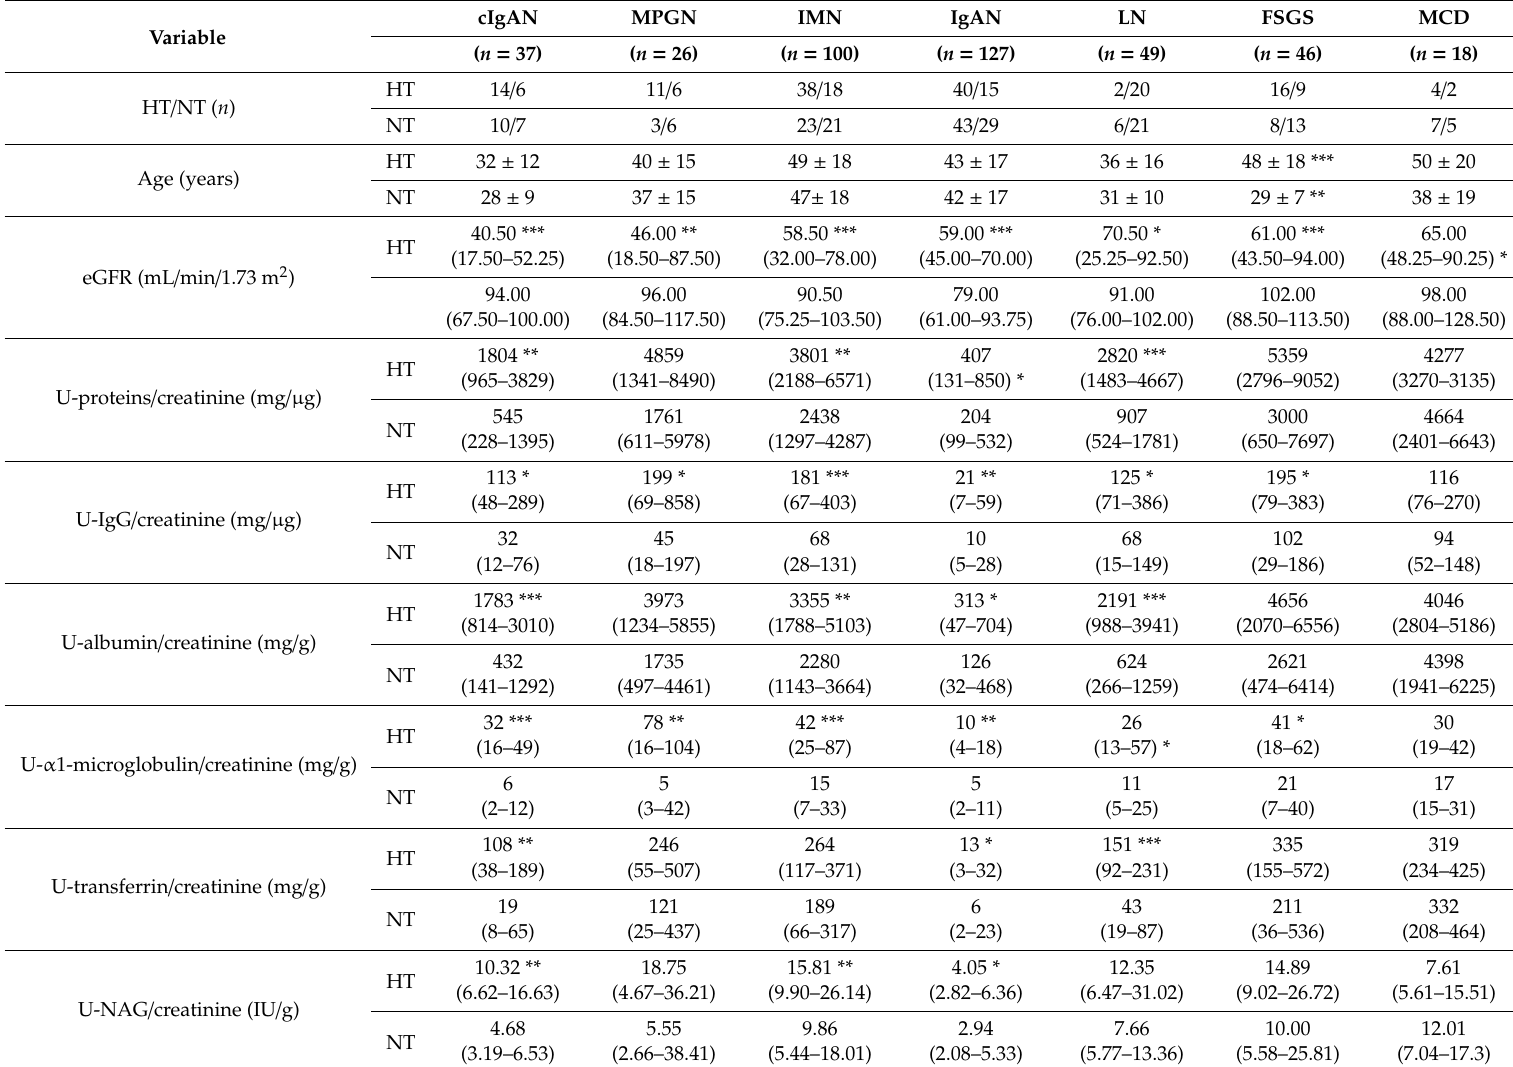
Table A2. Renal function in the patients with GN and with / without